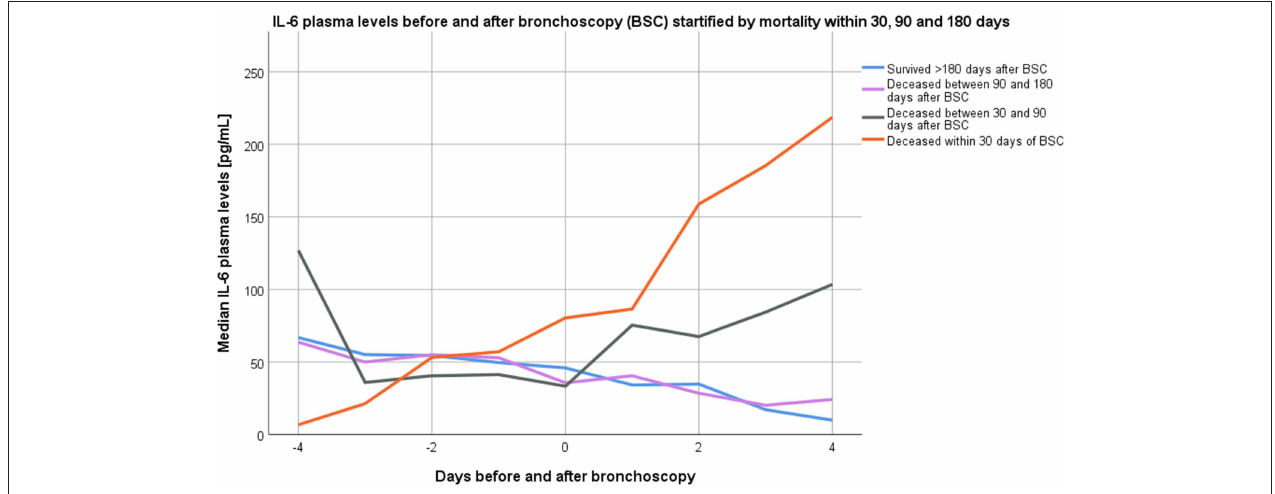
FIGURE 3 | Kinetics of median interleukin-6 plasma levels from 4 days before until 4 days after bronchoscopy stratified by overall mortality